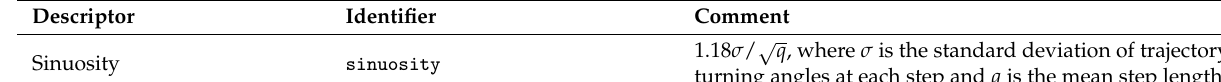
Table 2. The list of geometric descriptors that were used in this